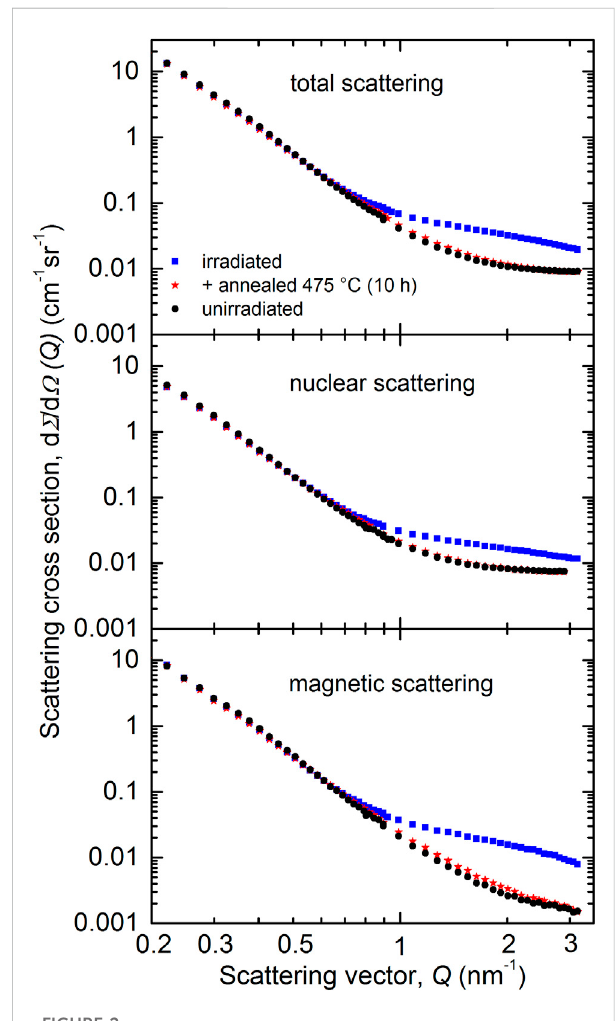
FIGURE 3 Measured total (upper plot), nuclear (center plot) and magnetic (lower plot) scattering cross sections for the post-irradiation annealed conditions (350 ° C – 450 ° C) of the weld material. For comparison, the unirradiated and as-irradiated conditions are reproduced from Figure 2 as